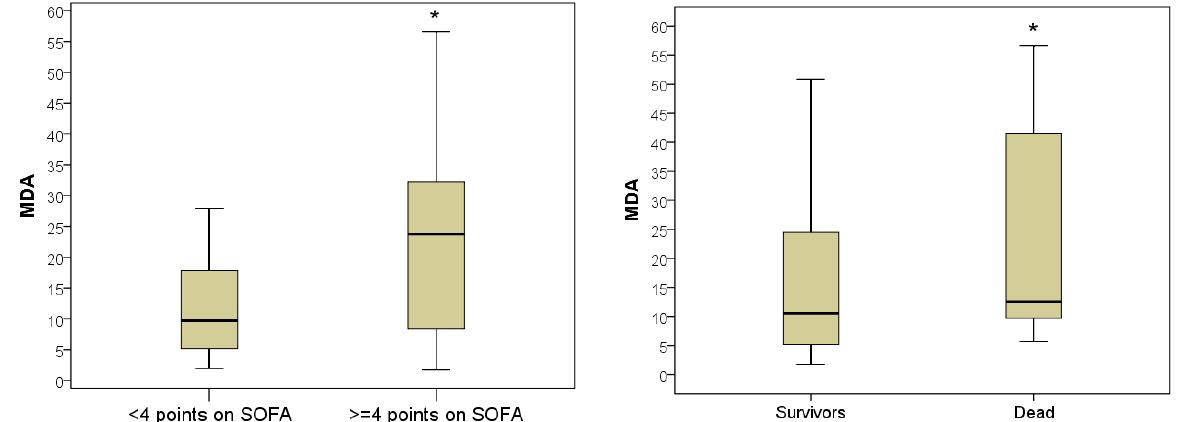
Figure 5. Malondialdehyde levels in blood plasma during hospitalization of severe and non-severe patients, and association with favorable and unfavorable hospital outcome (*—the difference between the two groups according to the Mann–Whitney criterion at p < 0.05).